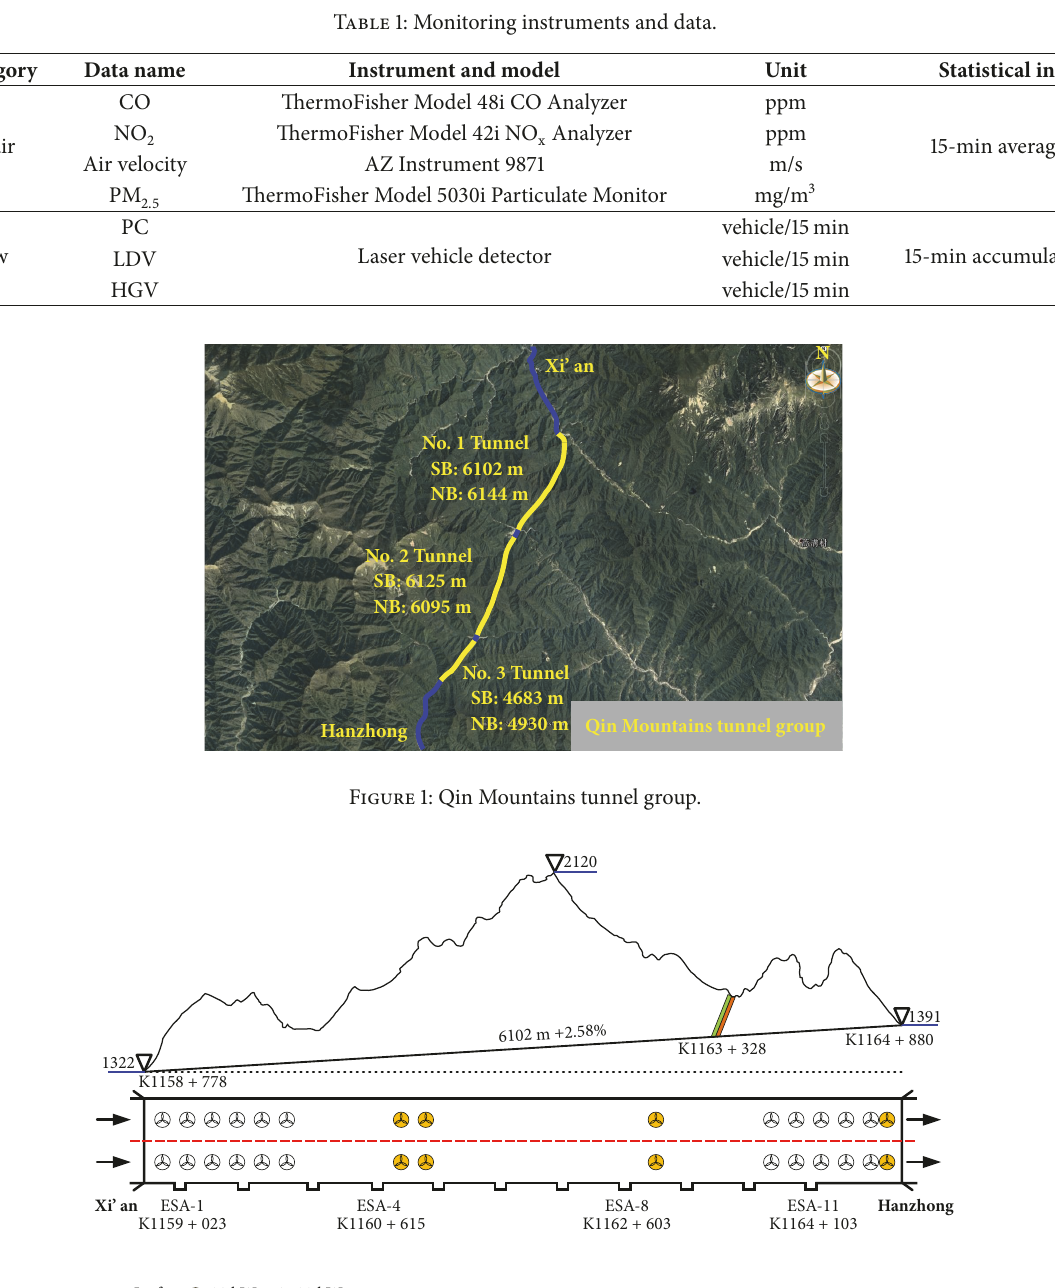
Figure 2: Overall structure of Qin Mountains No. 1 tunnel in the southbound